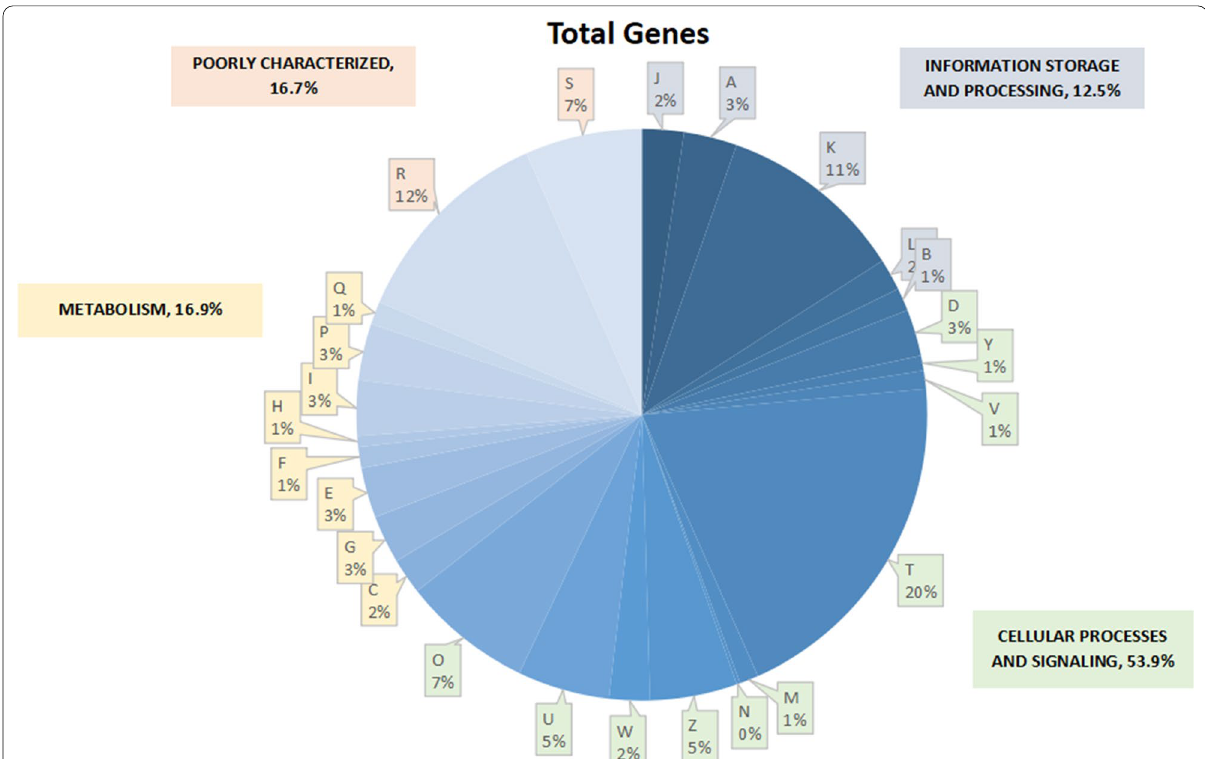
Fig. 4 KOG functional classification analysis of total